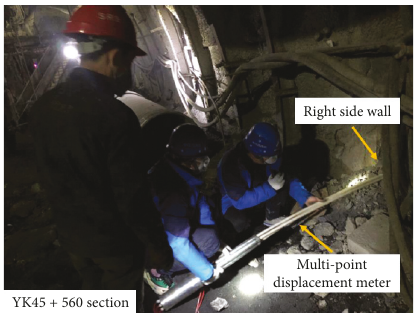
Figure 18: Installation process of the multipoint displacement meter